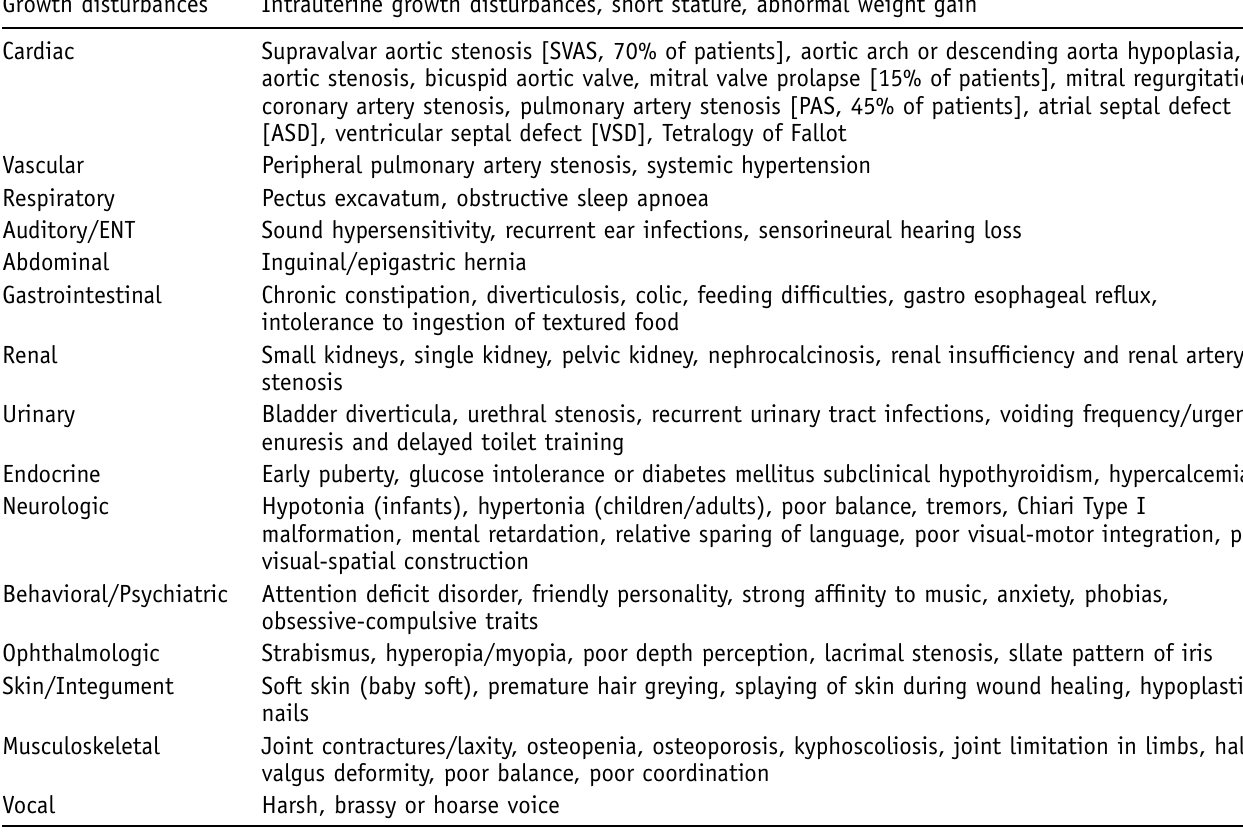
Table I. Clinical features of Williams – Beuren syndrome. Growth disturbances